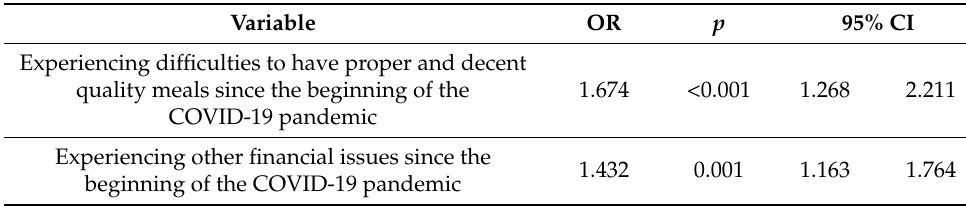
Table 5. Adjacent category logistic